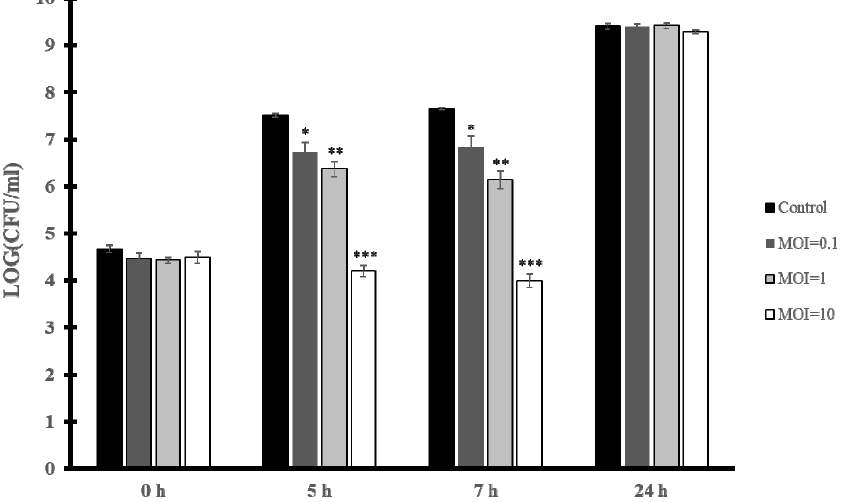
Figure 6. Biocontrol assay. E. faecium VR-13 10 4 CFU/mL culture infected with phage vB_EfmH_163